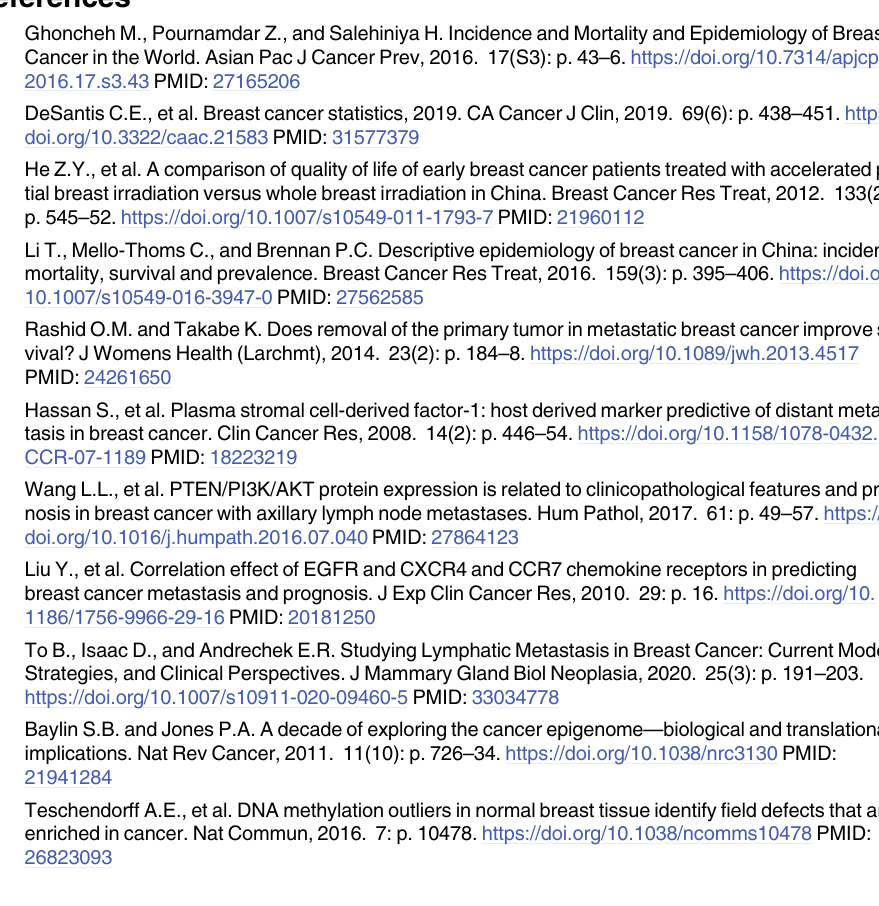
S2 Table. Methylation levels at each site in each breast cancer sample. S3 Table. Methylation levels at each site in each ER-positive and HER2-negative breast cancer